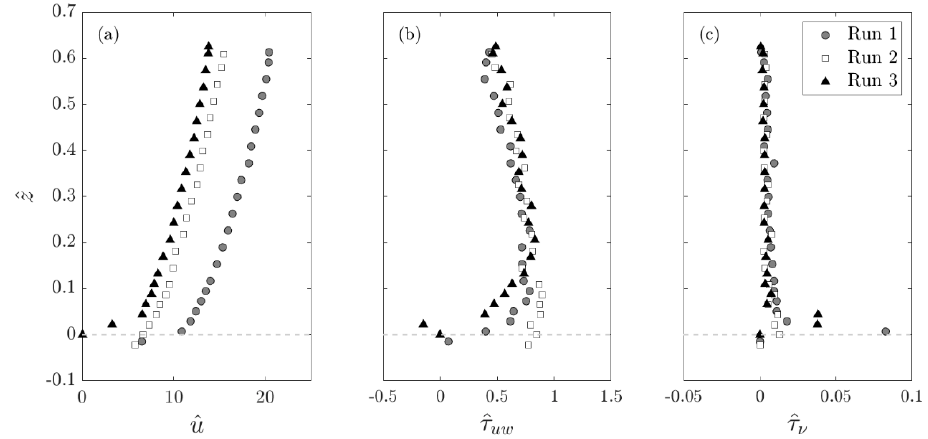
Figure 4. Vertical distributions of ( a ) dimensionless time-averaged velocity, ( b ) dimensionless Reynolds shear stress, and ( c ) dimensionless viscous shear stress for the approaching flow in Run 1, Run 2, and Run 3.